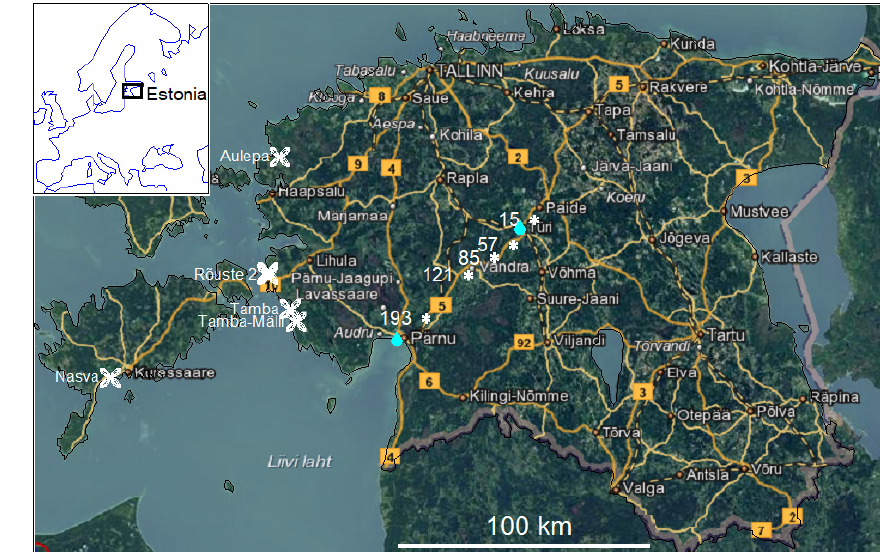
Figure 1. Coastal wind farms (white turbine images with site names), and wind measurement site at power line (withe asterisks with pole numbers indicated) in the map of Estonia. The meteorological observation stations Pärnu (costal) and Türi (inlnd) are indicted with light-blue drops. Base map: Land Board of Republic of Estonia (https://xgis.maaamet.ee/xgis2/page/app/maainfo, last access: 19 June 2020).